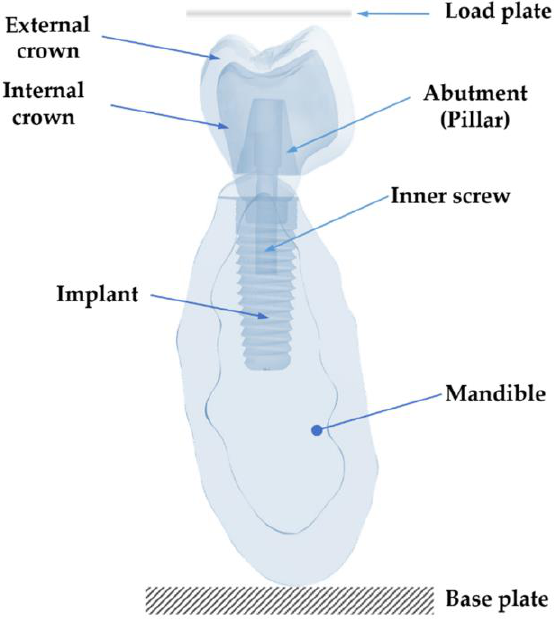
Figure 14. Longitudinal-section view of the whole 3D model: load plate, crowns, pillar, inner screw, implant, cortical and cancellous bones.